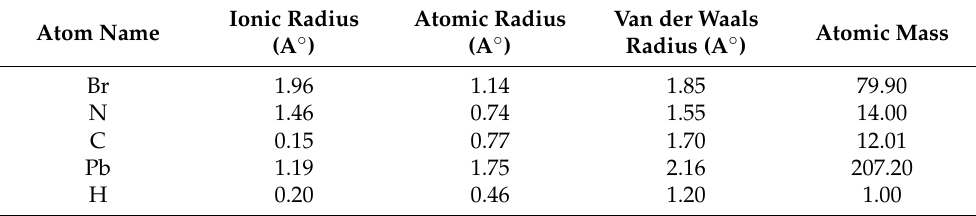
Table 2. Ionic radii; atomic radii; Van Der Waals radii; and atomic masses of I, Pb, N, C, and